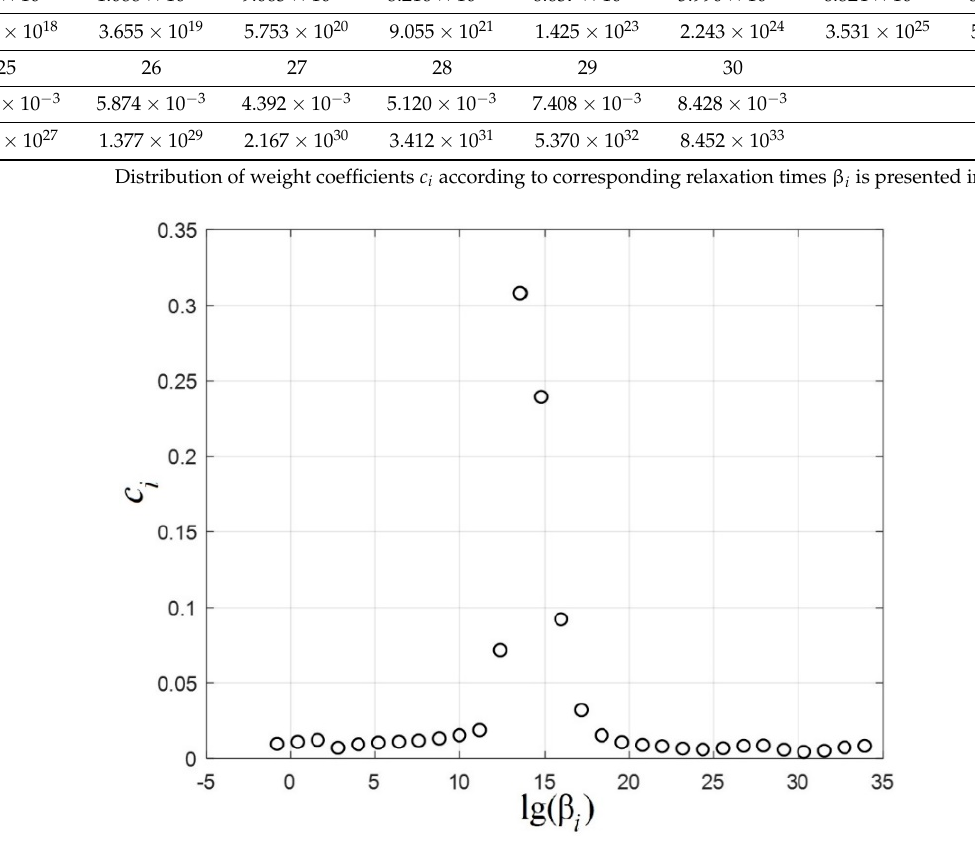
. Figure 10. Distribution of weight coefficients c i according to corresponding relaxation times β i (cid:3036)